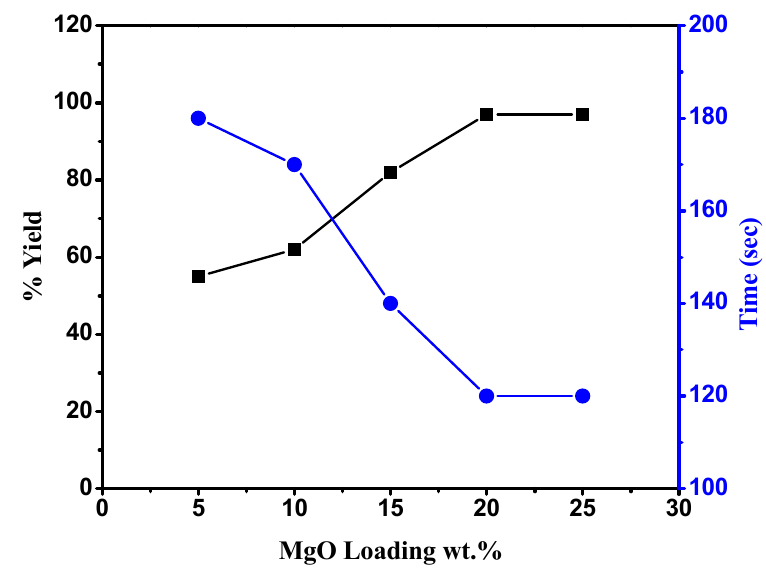
Figure 4. Optimization of the loading of CS-MgO film as a basic catalyst.